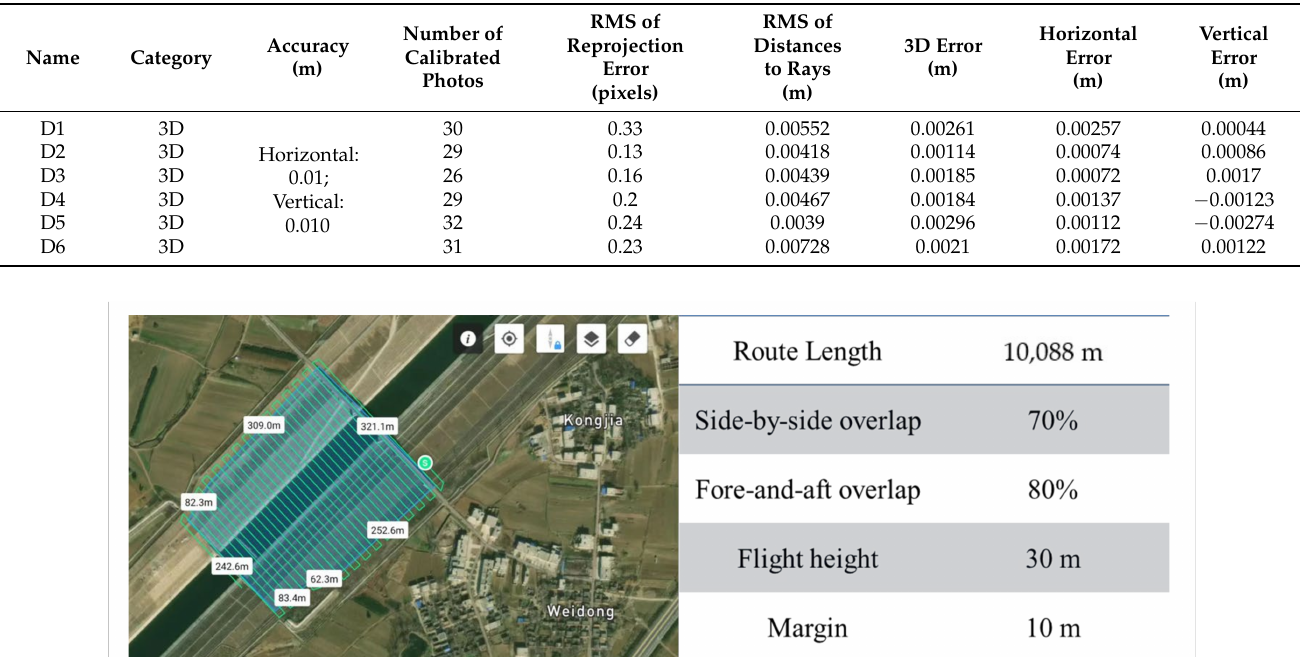
Table 1. Control points’ error table.